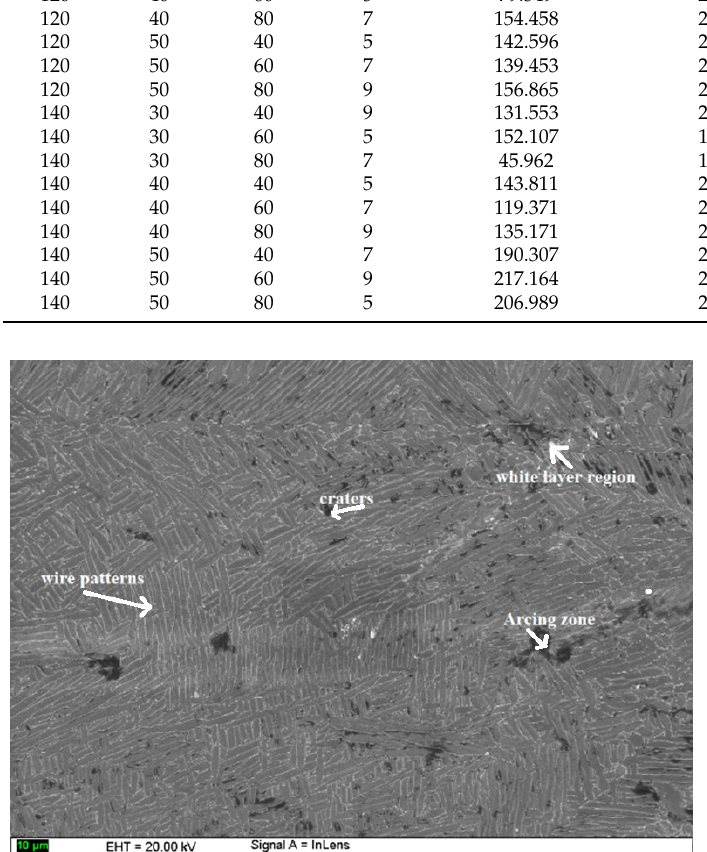
Figure 5. Surface morphology analysis of machined specimen under the factors of trial 26: ( a ) Three dimensional view; ( b ) Two dimensional view, and ( c ) Histogram analysis .